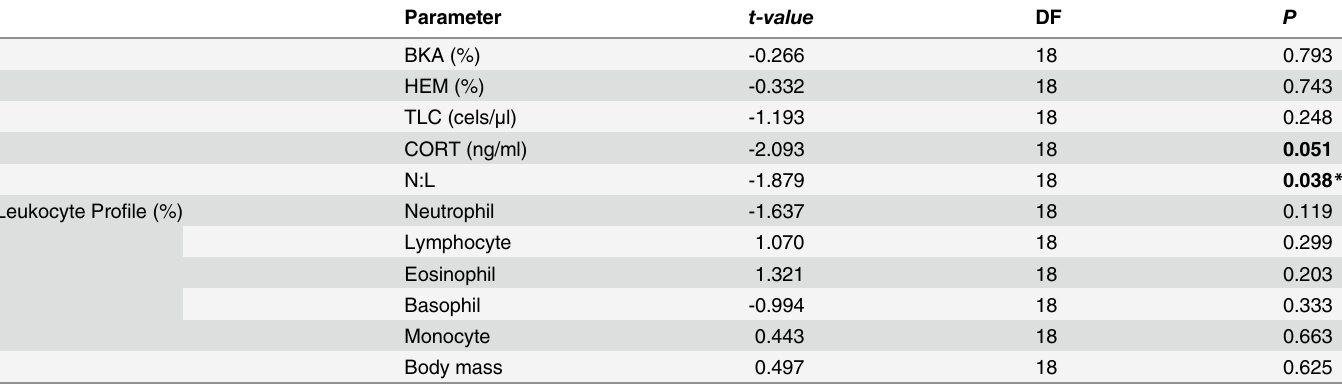
Table 5. Comparison between blood parameters and body mass for individuals of R . icterica after 24h of restraint challenge with and without movement restriction.